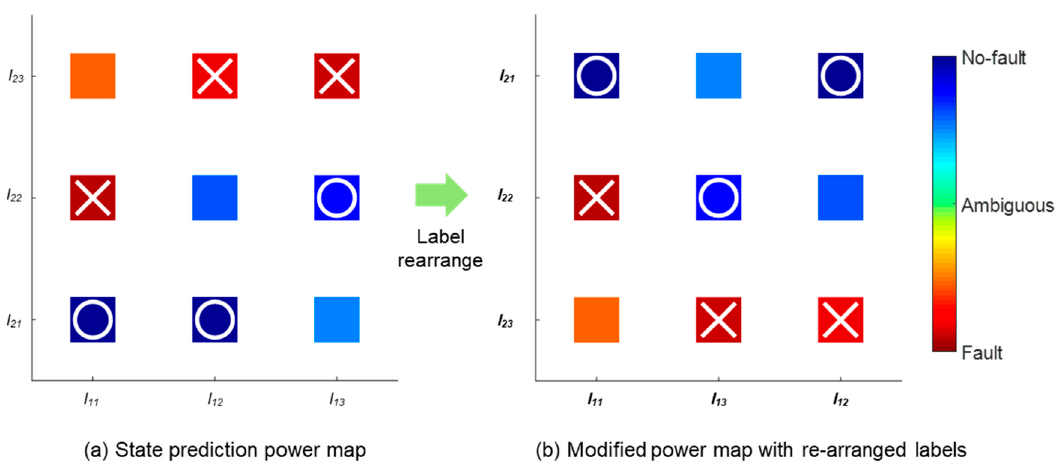
Figure 5. State prediction power map and label rearrange for fault region visualization.